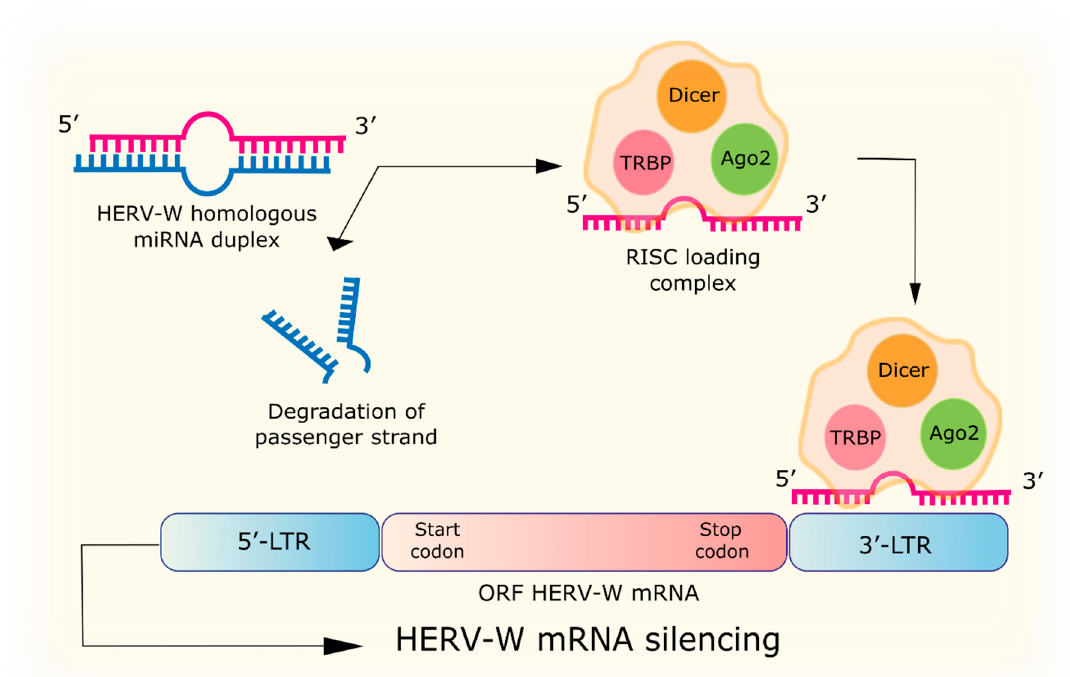
Figure 2. The mechanism of RNA interference. The Dicer enzyme cleaves specific to HERV ‐ W double ‐ stranded miRNA and promotes the loading of each strand into the RISC complex. Dicer binds to the transactivating response RNA ‐ binding protein (TRBP) to facilitate the transfer of dsRNA fragments to Argonaute 2 (Ago2). The least stable 5 ′ end RNA strand is integrated with the Ago2 protein in RISC, and the second passenger strand is degraded. The RISC complex with guide strand miRNA complementary binds to the 3 ′‐ LTR of the mRNA HERV ‐ W and silences it.